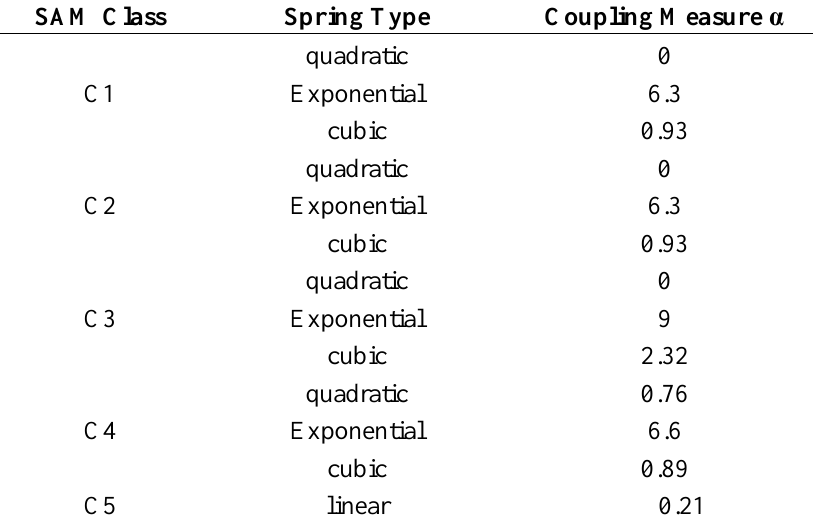
Table 2. Coupling between external force and the stiffness in different stiffness adjustment mechanism (SAM) classes using different types of